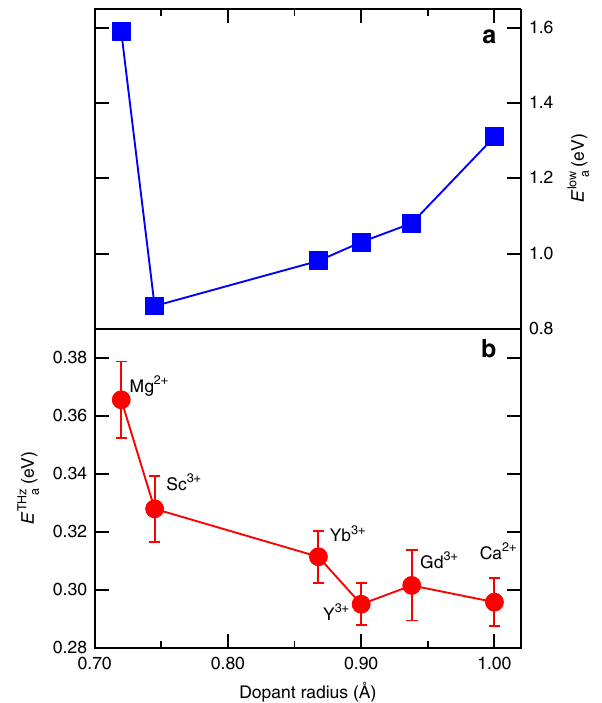
Fig. 6 The activation energies for stabilized zirconia samples with different dopant ions. a The low-frequency activation energy obtained by impedance measurements. b The activation energy in the THz regime obtained